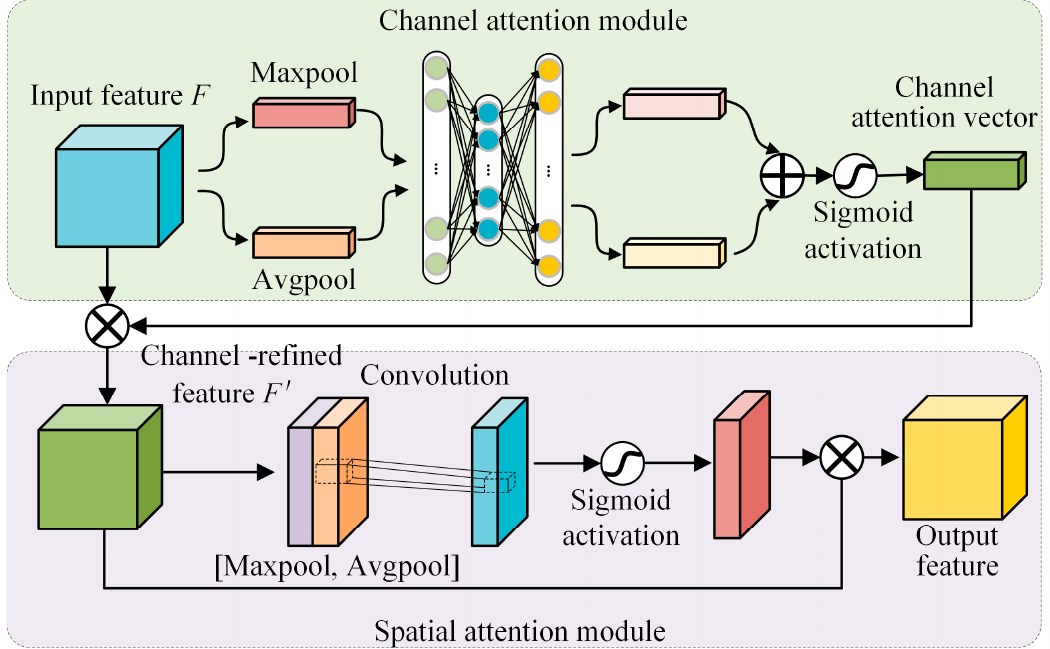
Figure 2. The basic structure of the